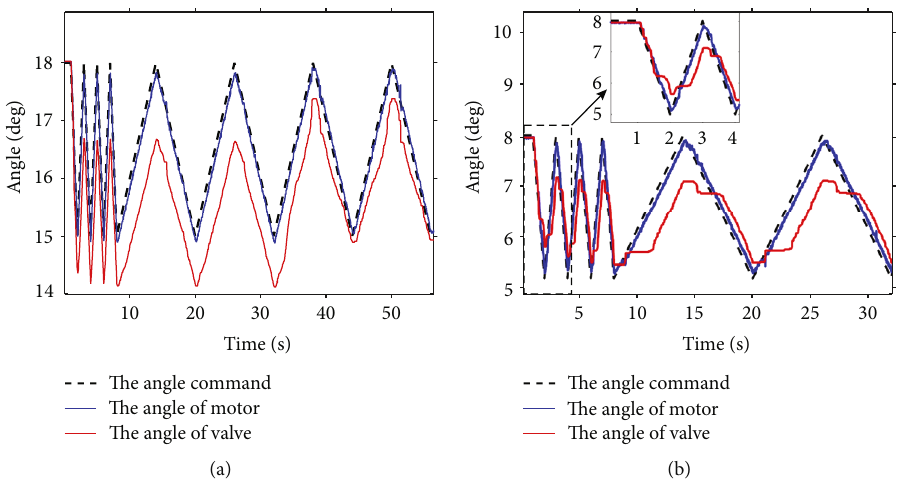
Figure 12: Valve response under a triangular wave (second experiment). (a) Reaction between 15 – 18 degrees. (b) Reaction between 5 – 8